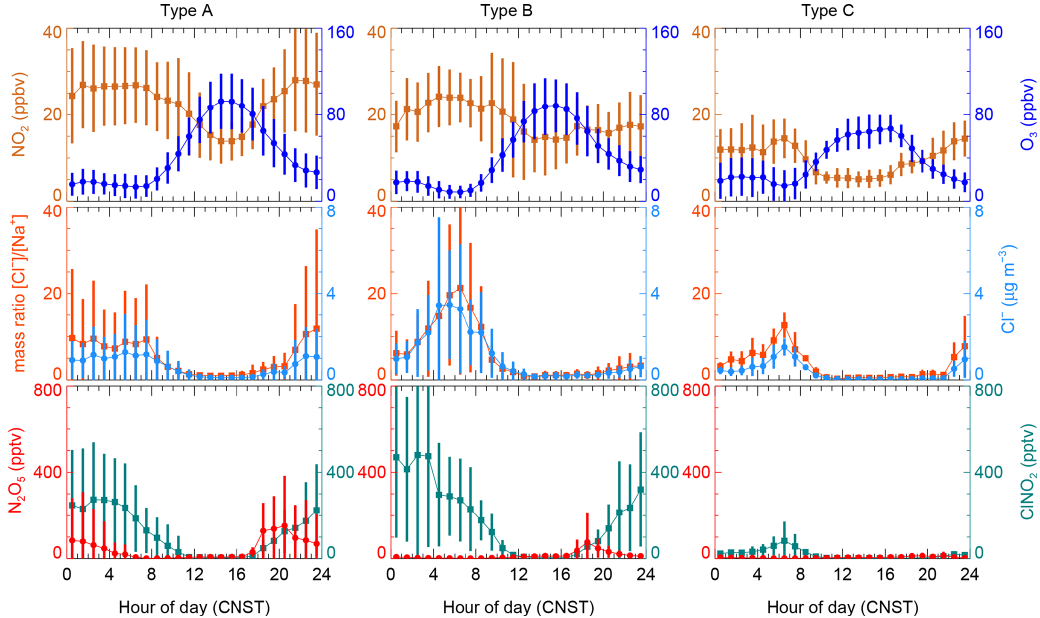
Figure 3. Mean diurnal profiles of N 2 O 5 , ClNO 2 , and relevant parameters in the three types of air masses.